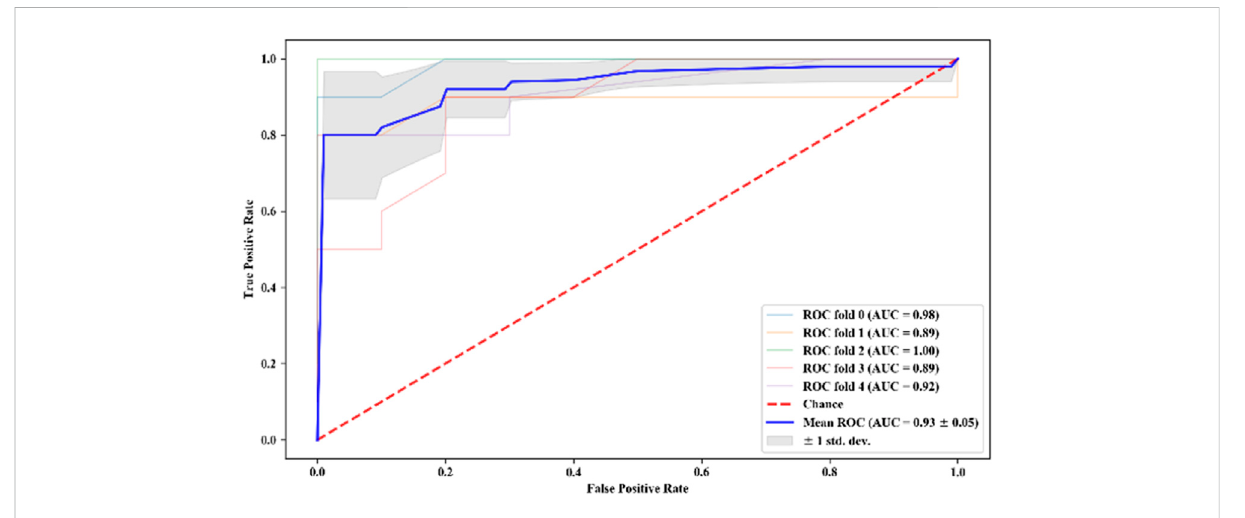
FIGURE 11 ROC curve of the AdaBoost ground fault classi fi cation